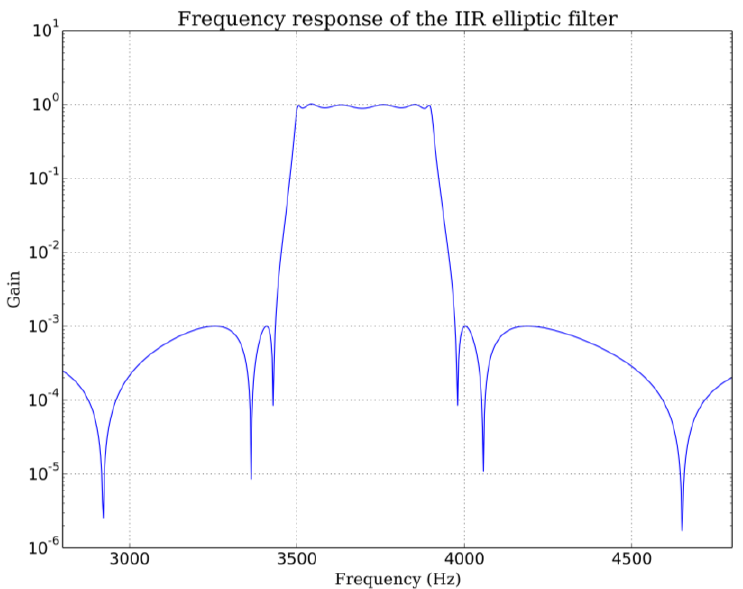
Figure 9. Frequency response of the IIR elliptic